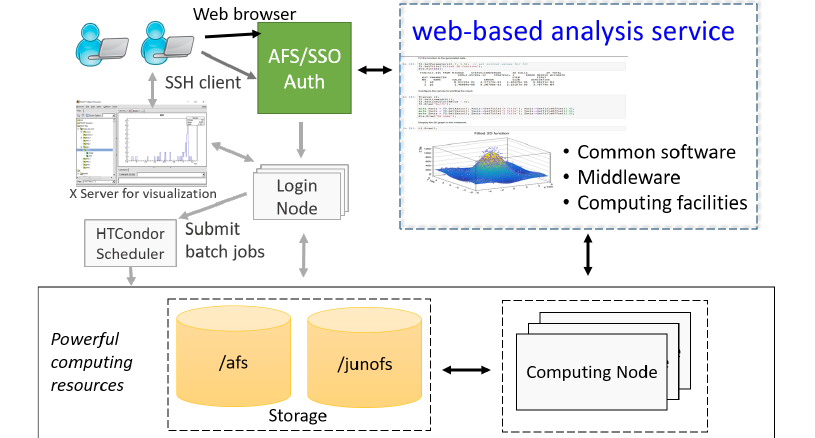
Figure 2. Schematic view of integration of ROOT and interactive